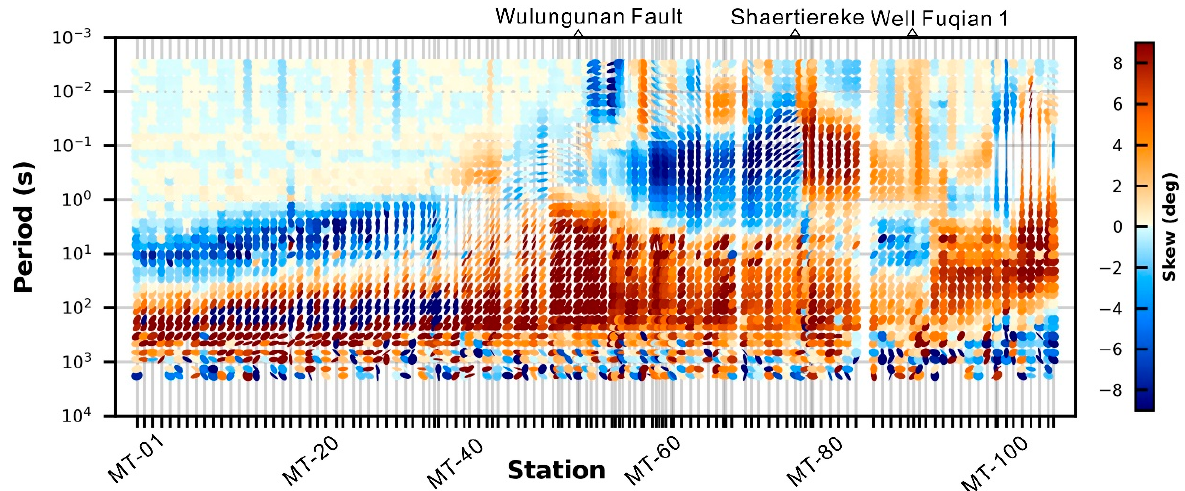
Figure 4. The phase tensor ellipses of each MT station at different period bands. Phase tensor ellipses are shaded according to skew value. The small value of the skew angle indicates that one of the principal axes of the phase tensor is oriented close to the regional strike direction in 2D and 3D cases.